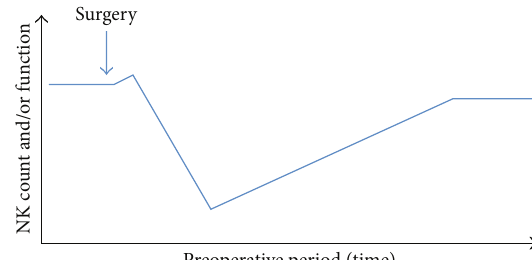
Figure 1: Commonly observed biphasic response in natural killer (NK) cell count and activity during and after